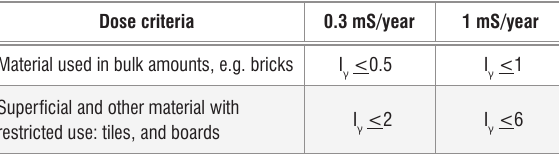
Figure 2. The 226 Ra and 210 Pb belong to the 238 U natural decay series and are not in secular equilibrium in the LSA phosphogypsum. Although the linear trend of the ratio of these two radionuclides is close to unity, there coefficient (R 2 ) of 0.133. The uranium radioactive nuclide 238 U is also in disequilibrium with its progeny 226 Ra. Similarly, 235 U is in disequilibrium with 210 Pb and disequilibrium is also observed between 232 Th versus 228 Ra and 228 Ra versus 228 Th.